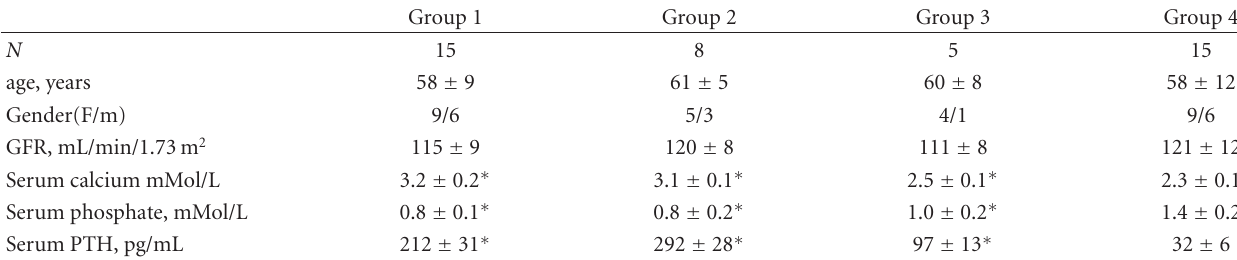
Table 1: Characteristics of patients with PHPT (Group 1–3) and age-and sex matched normal subjects (Group